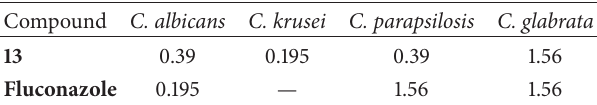
Table 2: Minimum inhibitory concentration (MIC) in 𝜇 mol/mL of 13